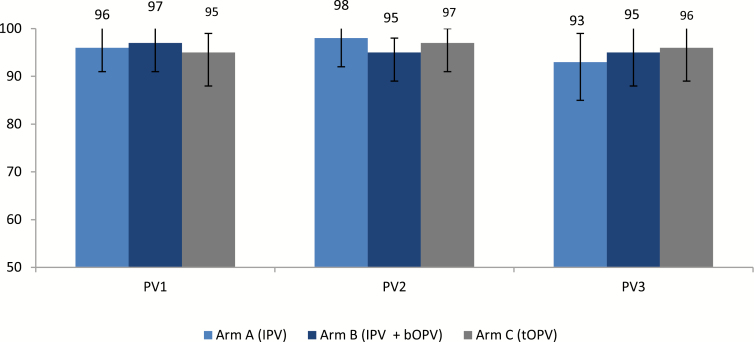
Seroconversion (% and 95% confidence interval]) after 1 dose of IPV (Arm A), 1 dose of IPV+bOPV (Arm B), or 1 dose of tOPV (Arm C). Abbreviations: bOPV, bivalent oral poliovirus vaccine; IPV, inactivated poliovirus vaccine; PV1–3, polyvirus types 1–3; tOPV, trivalent oral poliovirus vaccine.